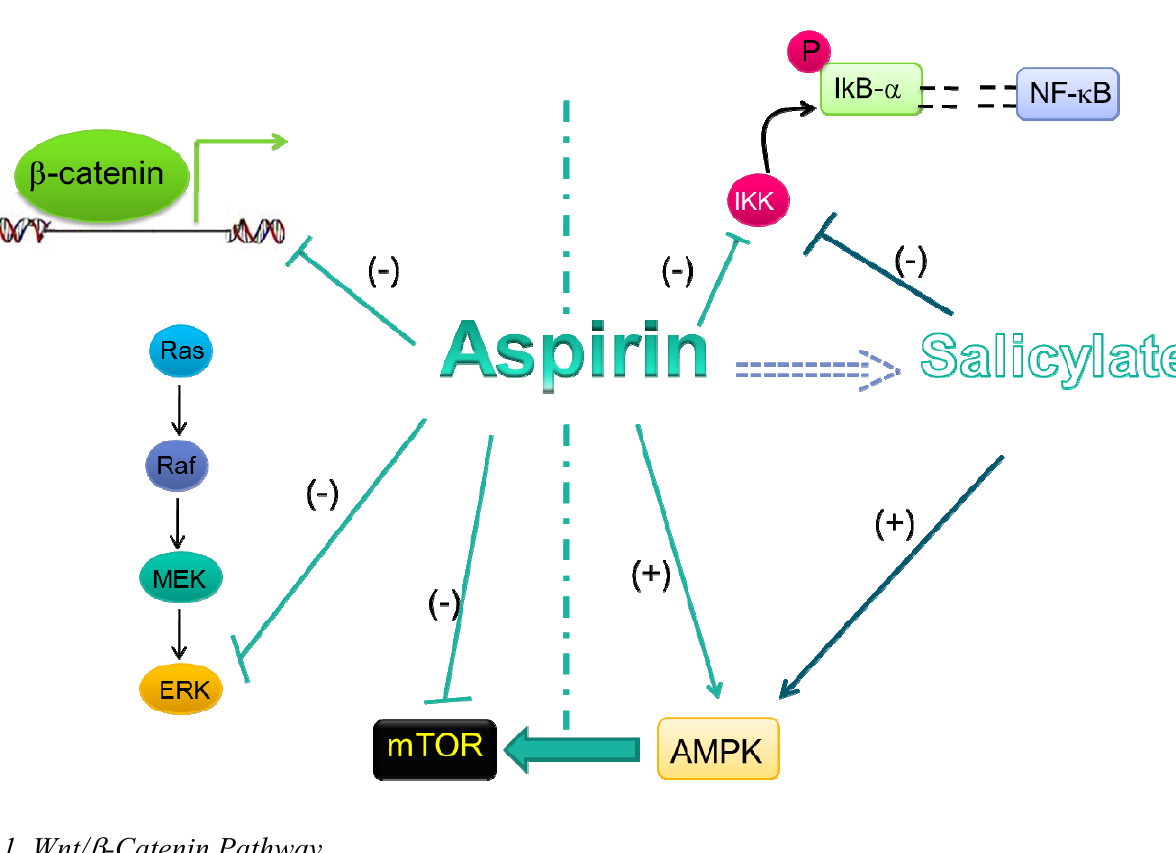
Figure 2. COX-independent mechanisms of the antitumoral effects of high-doses of aspirin and